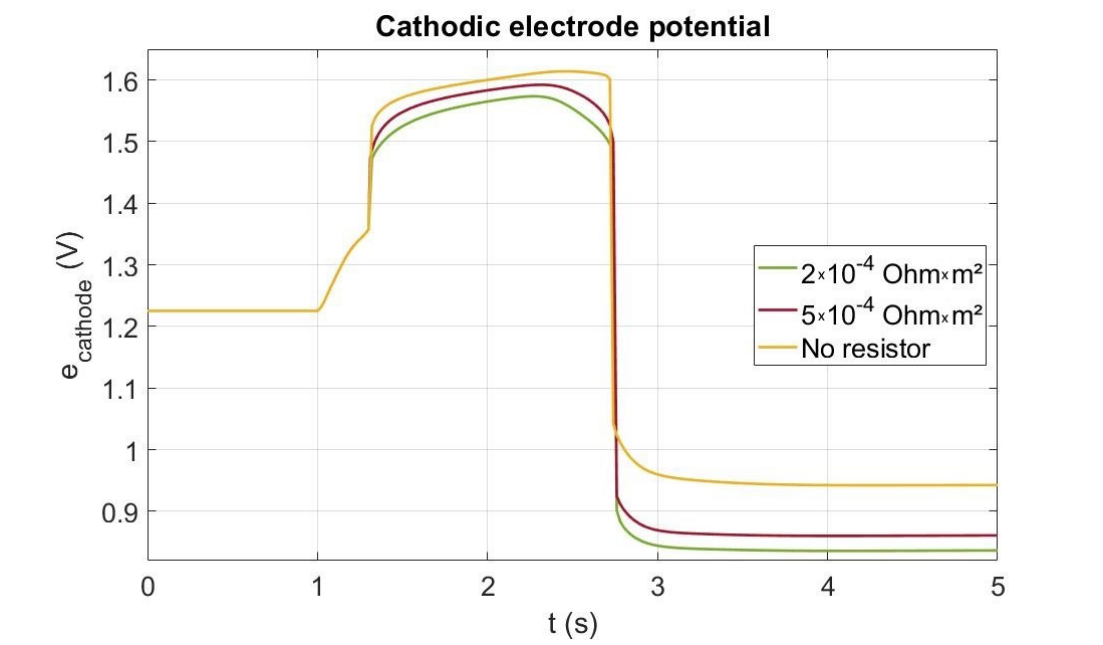
Figure 8. Electrode potential at the cathode inlet during a startup without and with a